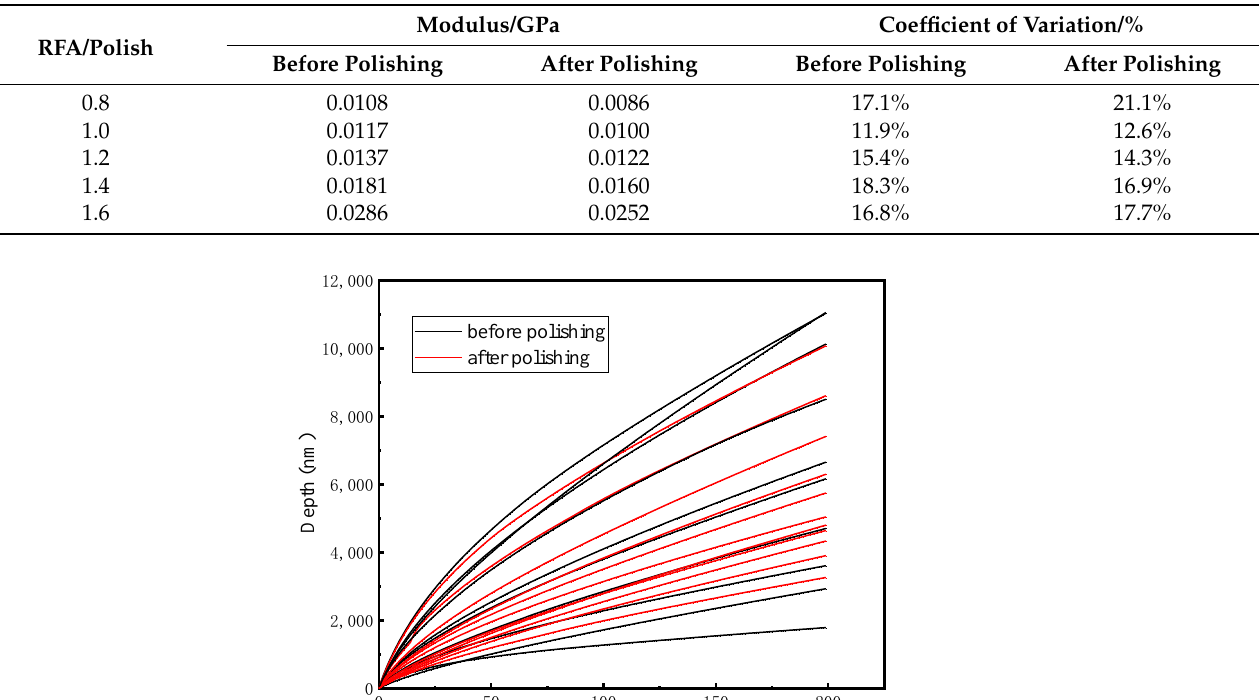
Figure 10. Nanoindentation creep curve before and after polishing of asphalt mastic specimens with RFA of 0.8. Table 4. Nanoindentation modulus of asphalt mastic specimens before and after polishing.